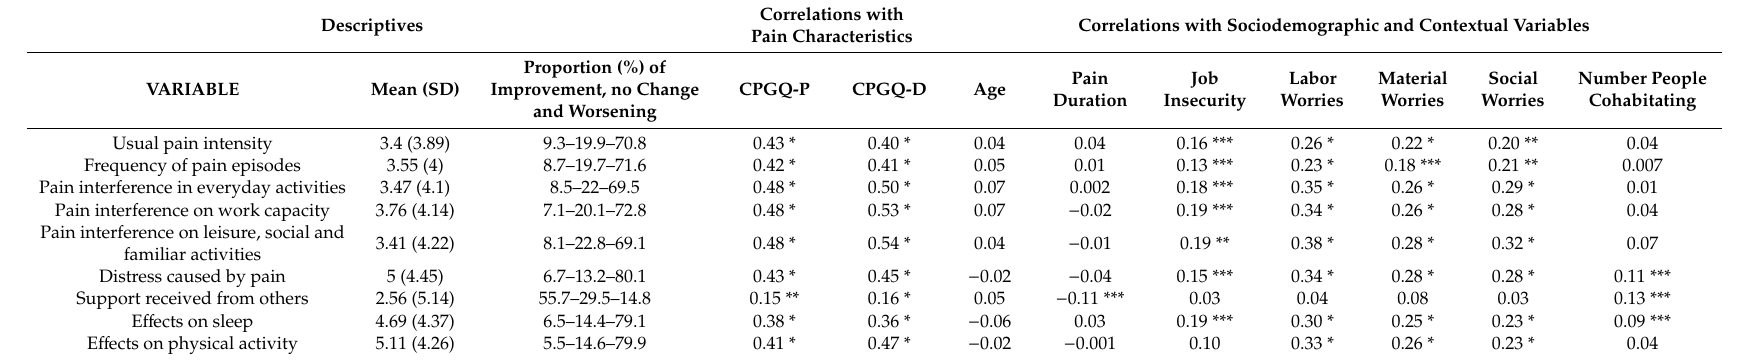
Table 2. Perceived changes in pain and pain-related outcomes, and correlations between study variables.